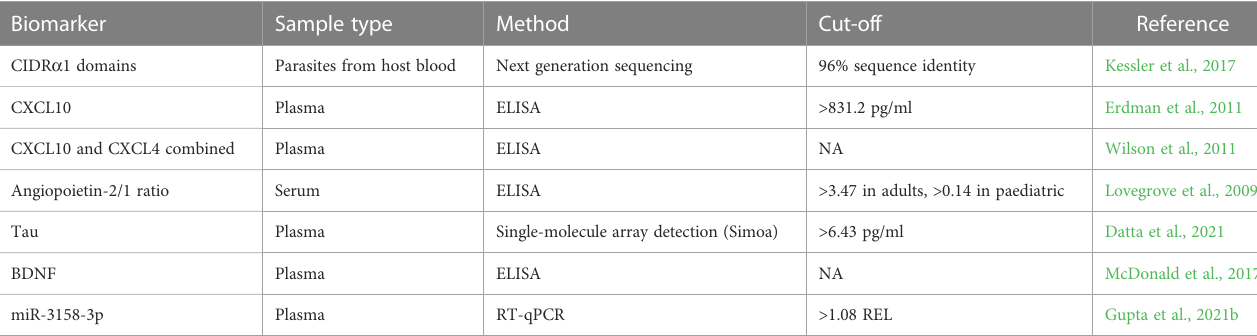
TABLE 1 Promising host and parasite factors-based CM biomarkers identi fi ed in humans.